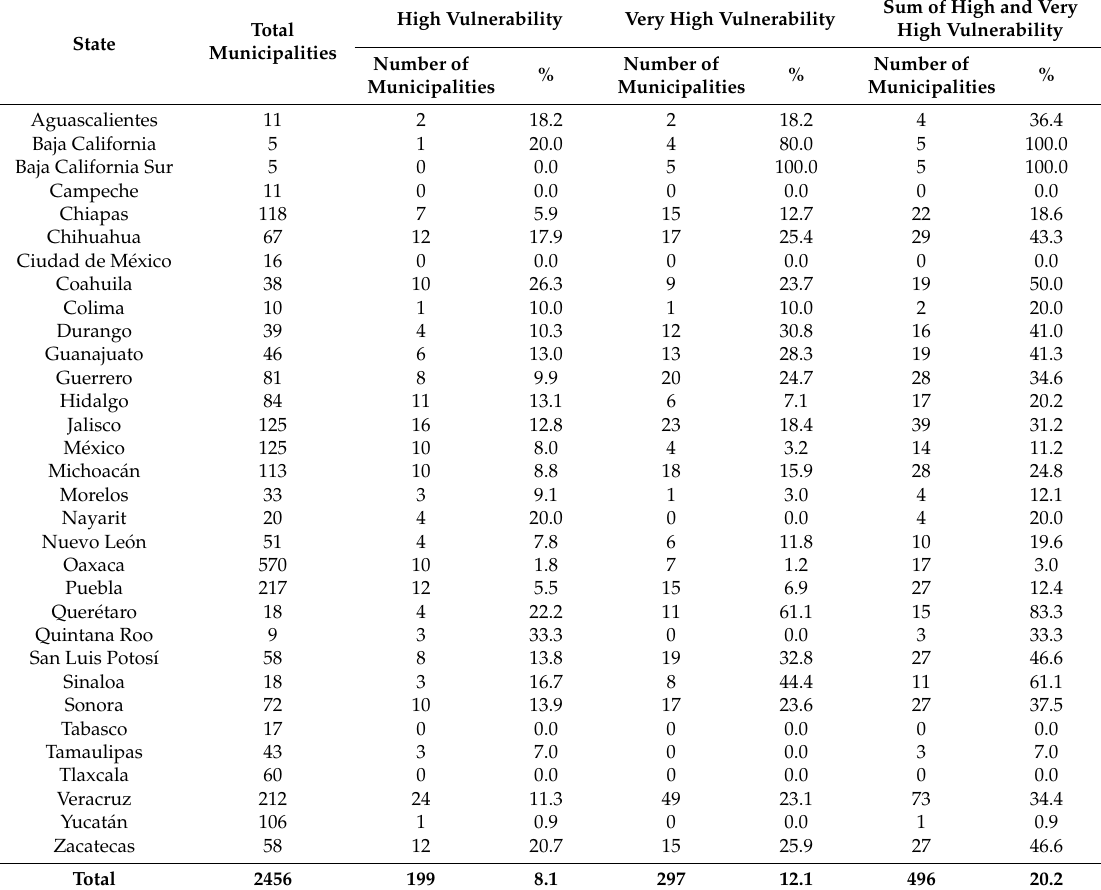
Table A4. Environmental vulnerability. Number of municipalities by state and percentages of municipalities with high and very high environmental vulnerability by state.